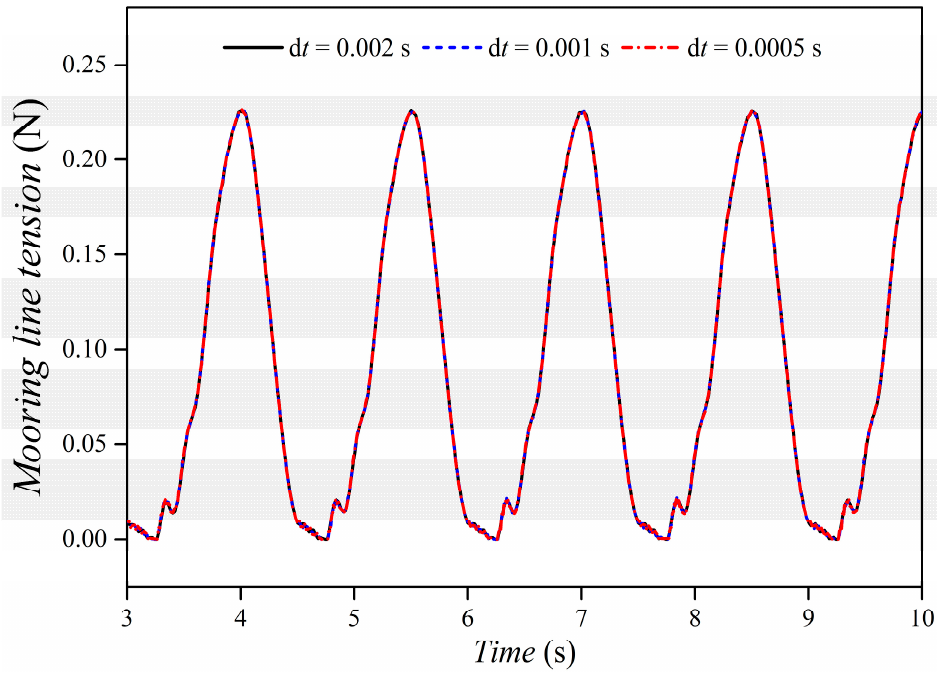
Figure 7. Convergence analysis results.